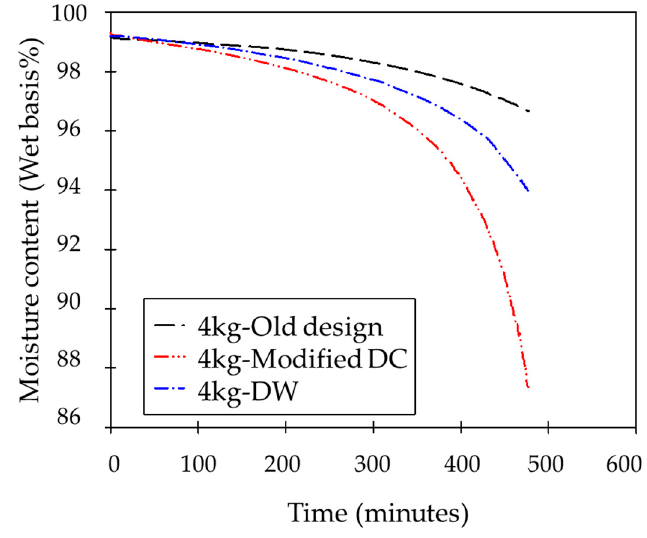
Figure 9. Variation in the moisture content at the minimum test load.